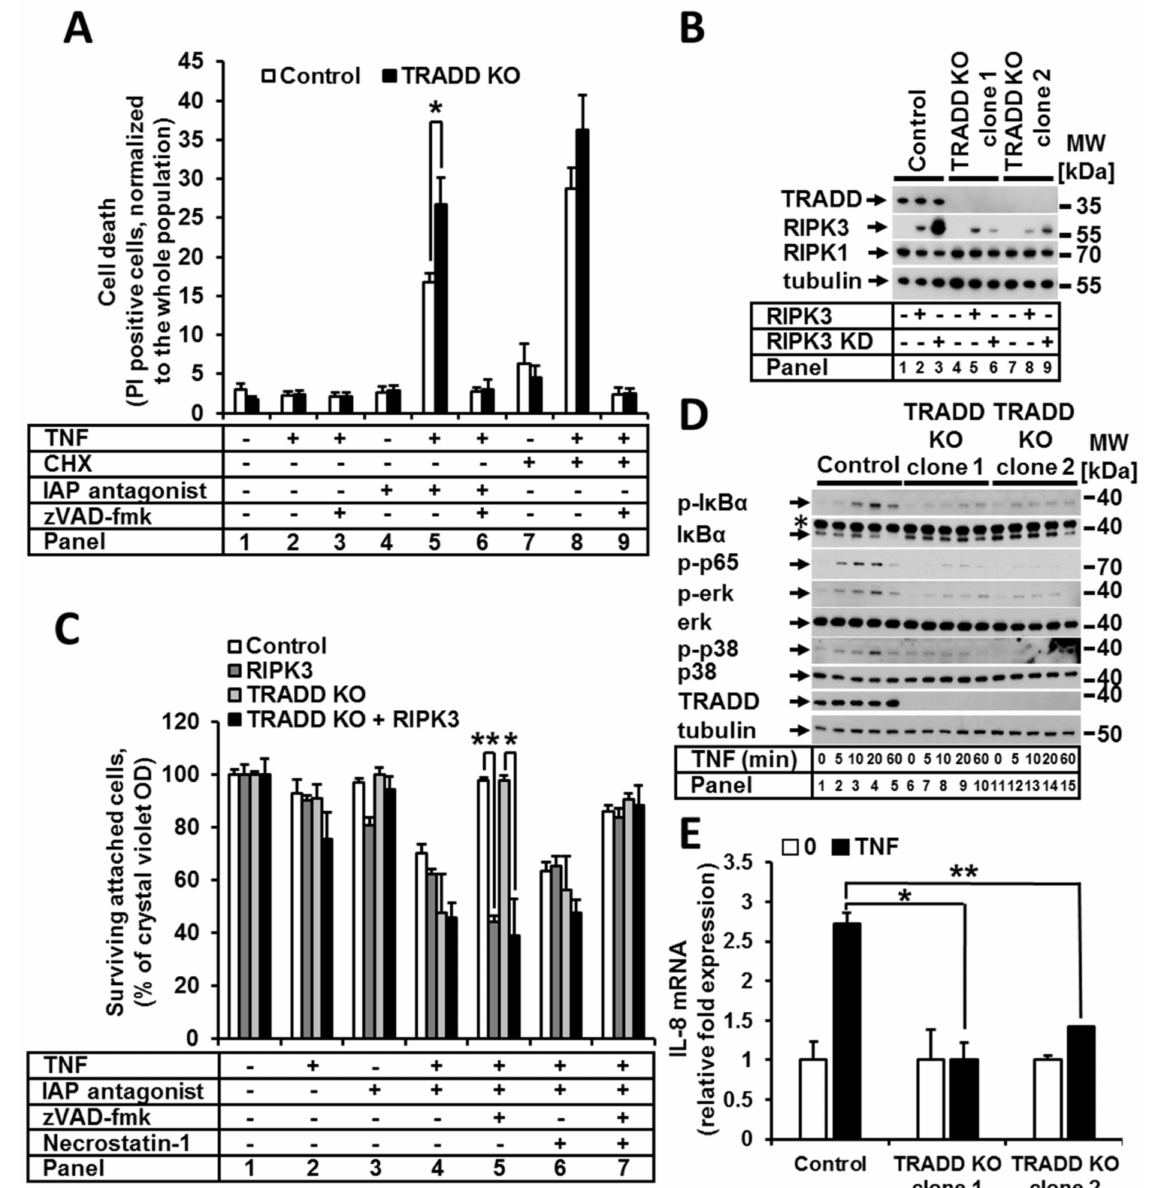
Figure 4. TRADD was significant for TNF-induced apoptosis and non-cell death signaling but was irrelevant for necroptosis. ( A ) Control and TRADD KO cells were treated as indicated, and cell death was analyzed by PI staining and FACS analysis. ( B ) Protein expression in control cells and TRADD KO clones overexpressing RIPK3 or RIPK3KD was analyzed by WB. ( C ) Cells from ( B ) were treated as indicated and cell viability was analyzed by CV staining. ( D ) Control and TRADD KO cells were stimulated with TNF for the indicated time points, and cell lysates were analyzed by WB. ( E ) Control cells and TRADD KO clones were treated with TNF for 1 h, and mRNA expression of CXCL8 (IL-8) was analyzed by real-time qPCR. For each diagram, the mean values ( ± SEM) of three independent experiments are shown. The WB shown are representative of at least two independent experiments. Error bars represent the SEM. * p < 0.05, ** p < 0.01, *** p <